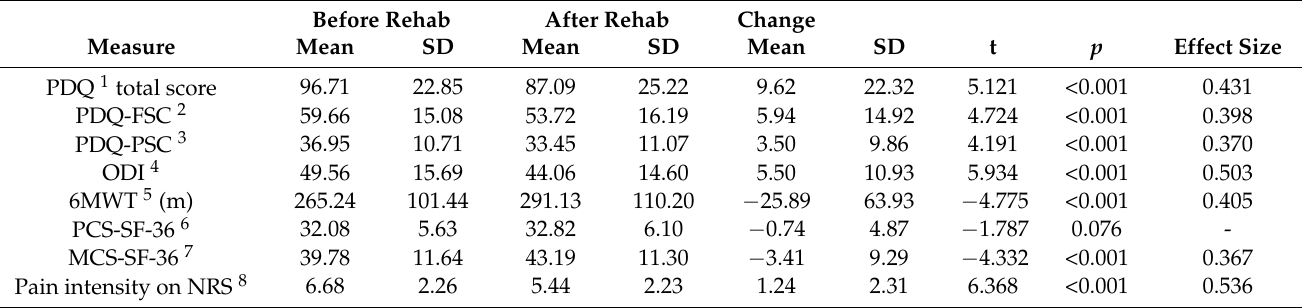
Table 6. Treatment responsiveness ( N =